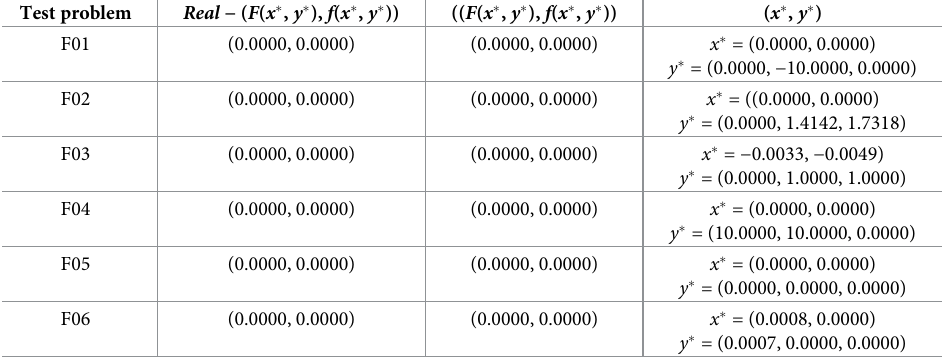
Table 1. Comparison between the results obtained by TCEA and the real objective values in the case of 5